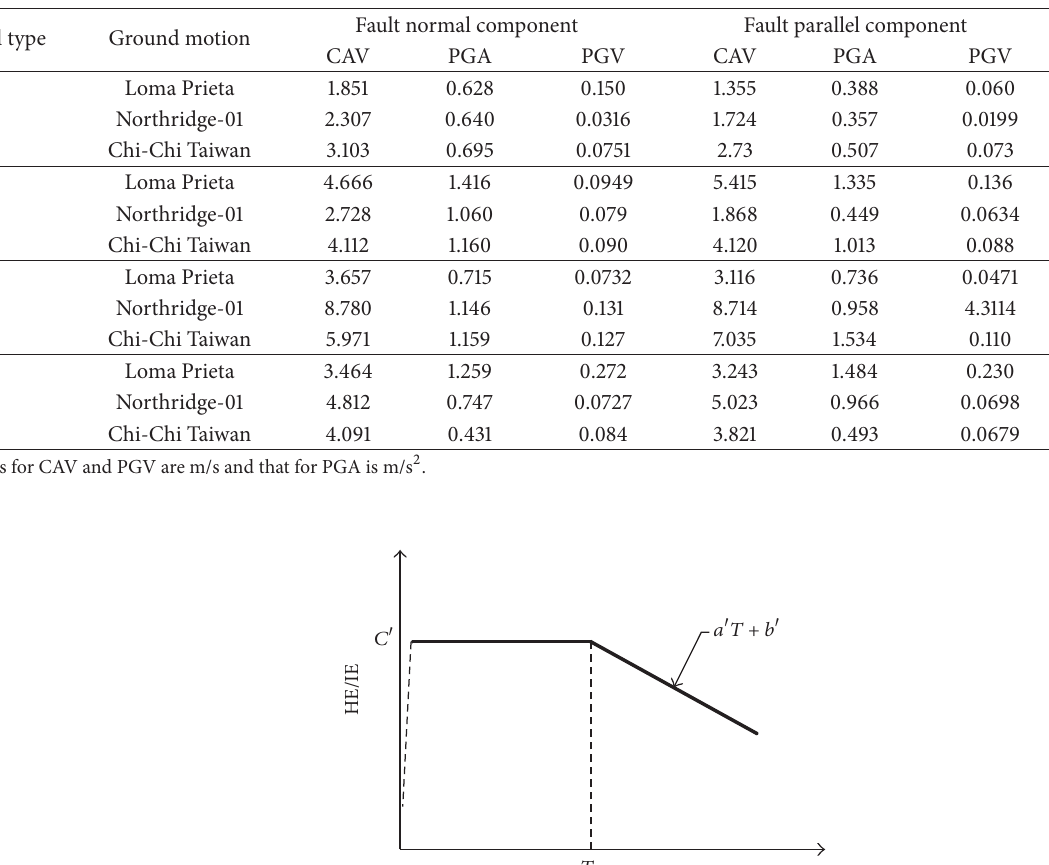
Table 11: Ground motion indices and scaling factor.